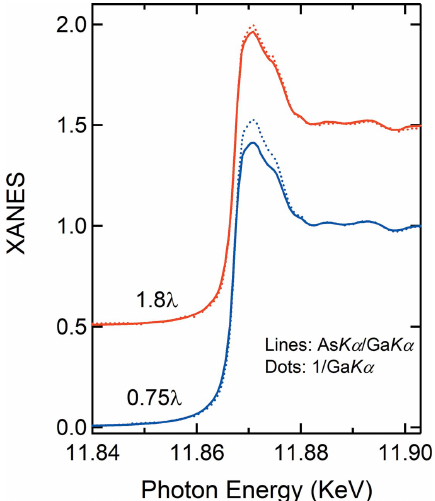
Figure 8 The sample thickness effects on the XANES spectra obtained using the normalization method and the IPFY method. The fluorescence data of GaAs powder were measured on the powder-on-tape samples whose optical thickness is 0.75 (cid:13) (Fig. 6) and 1.8 (cid:13) (Fig. S9),